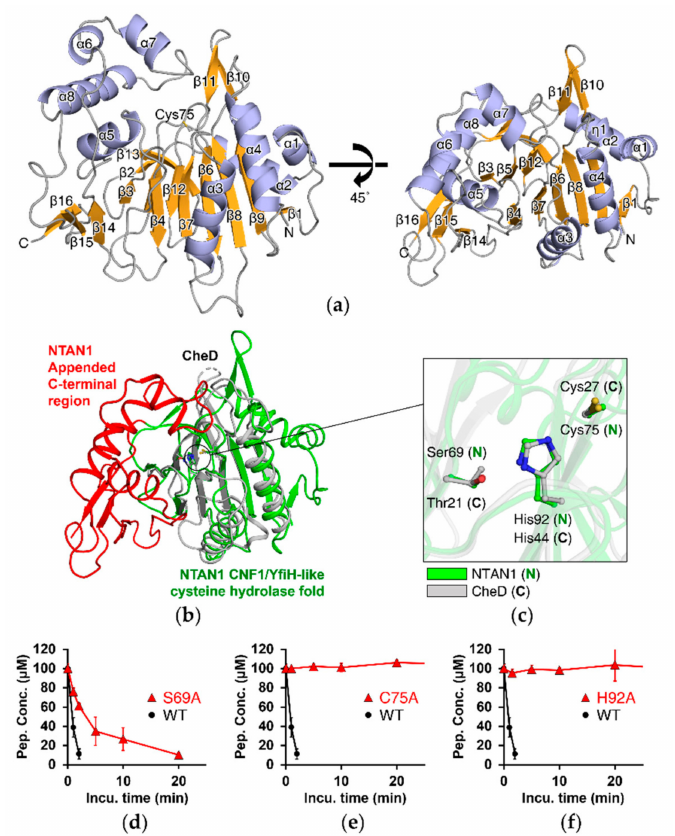
Figure 1. NTAN1 has a CNF1 / YfiH-like cysteine hydrolase fold with an appended C-terminal region. ( a ) The α - β - β sandwich structure of NTAN1. Helices (eight α -helices, α 1– α 8; and one 3 10 -helix, η 1), β -strands ( β 1– β 16), and loops are shown as cartoon representation colored in light blue, bright orange, and gray, respectively. The NTAN1 structure on the left-hand side is rotated vertically by 45 ◦ on the right-hand side to e ff ectively display the α - β - β sandwich structure and the catalytically crucial Cys75 in the active site. ( b ) Superposition of NTAN1 with CheD from Thermotoga maritima . CNF1 / YfiH-like cysteine hydrolase fold and appended C-terminal region of NTAN1 are colored in green and red, respectively. CheD is colored in gray. The active sites of both proteins are marked with a black circle. ( c ) Close-up view of the superposed active sites of NTAN1 and CheD. Catalytic triads of NTAN1 (Cys75 / His92 / Ser69) and CheD (Cys27 / His44 / Thr21) are shown as green and gray ball-and-stick models, respectively. Nitrogen, oxygen, and sulfur atoms are colored in blue, red, and yellow, respectively. ( d – f ) Deamidation by Ala-mutants of NTAN1 catalytic triad. Concentrations of the NRAAA peptide are plotted against incubation times with NTAN1 (wild type, WT) and the mutants, S69A ( d ), C75A ( e ), and H92A ( f ). Error bars indicate standard-deviation values of three independent